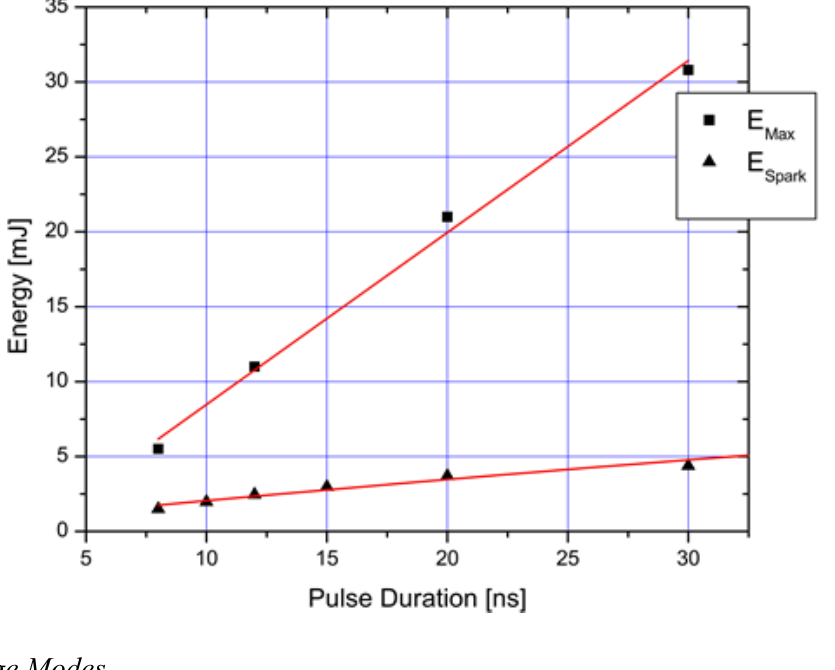
) on laser pulse Spark